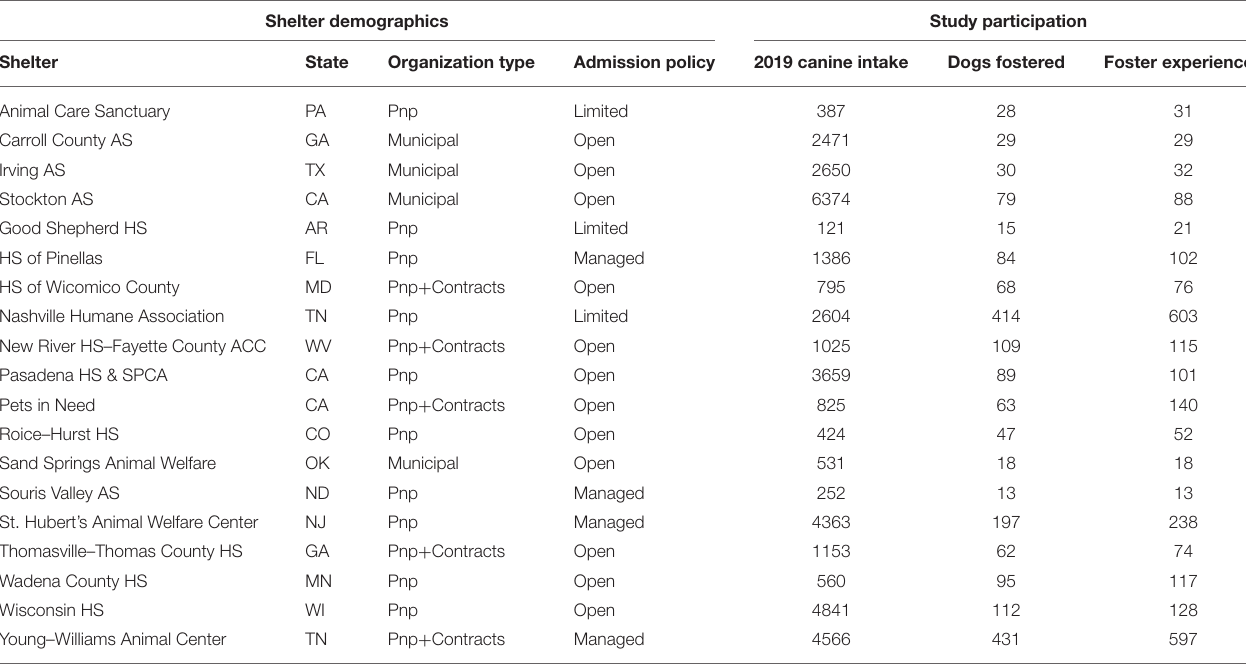
TABLE 2 | Location of animal shelter, organization type, admission policy, 2019 canine intake, and number of dogs fostered & foster experiences recorded (March 11–June 30, 2020). Shelter